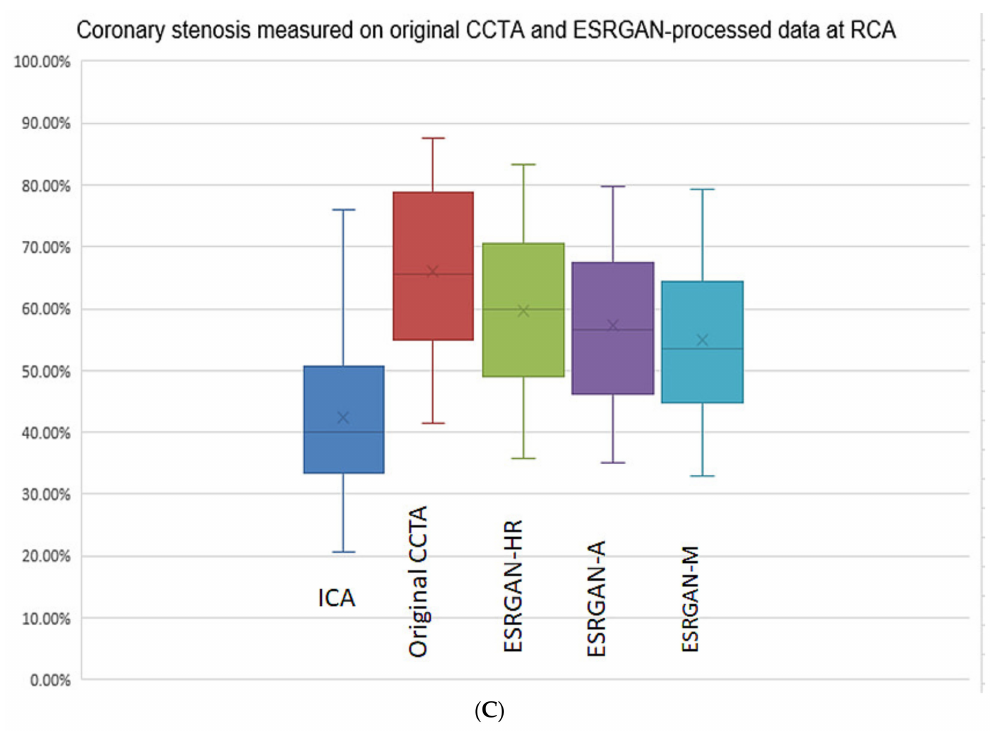
Figure 1. Boxplot showing the comparison of degree of coronary stenosis at LAD, LCx and RCA between original CCTA and ESRGAN-processed data with invasive coronary angiography as the reference. Although original CCTA and ESRGAN-processed images significantly overestimated the lumen stenosis than ICA, ESRGAN-Median images show better improvement than ESRGAN-HR and Average at these three coronary arteries levels ( A – C ). A-average; CCTA-coronary computed tomography angiography; ESRGAN-enhanced super-resolution generative adversarial network; HR-high-resolution; ICA-invasive coronary angiography; LAD-left anterior descending; LCx-left circumflex; M-median; RCA-right coronary artery.